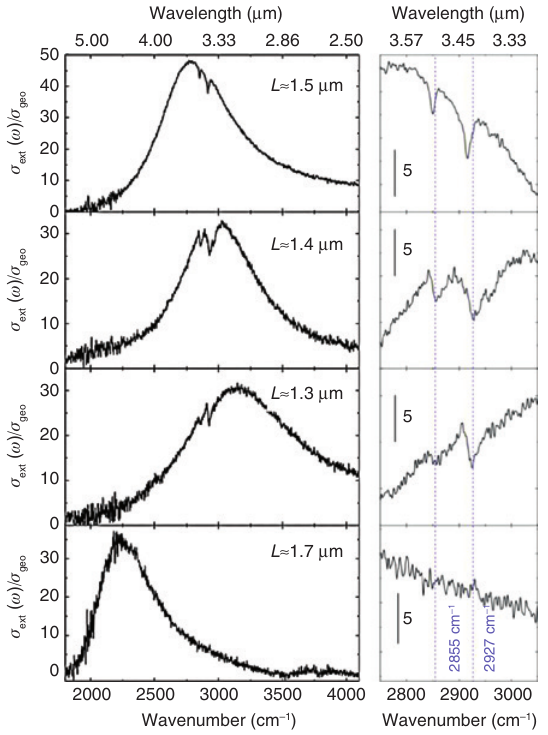
(normalized to ext ) for four ODT-coated wires with geo . To the right, the 2